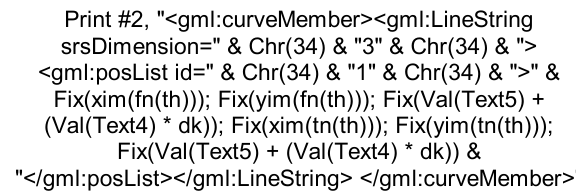
Figure 8. The five levels of detail (LOD) defined by CityGML (Gröger et al. 2008, source: IGG Uni Bonn).